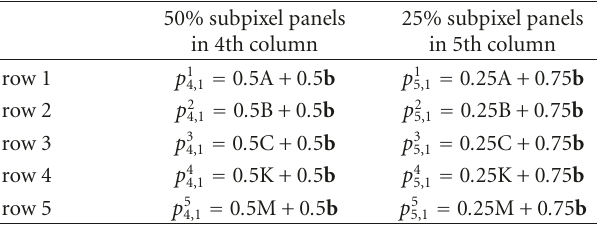
Table 2: Subpanel pixels in the 4th and 5th columns for simula-